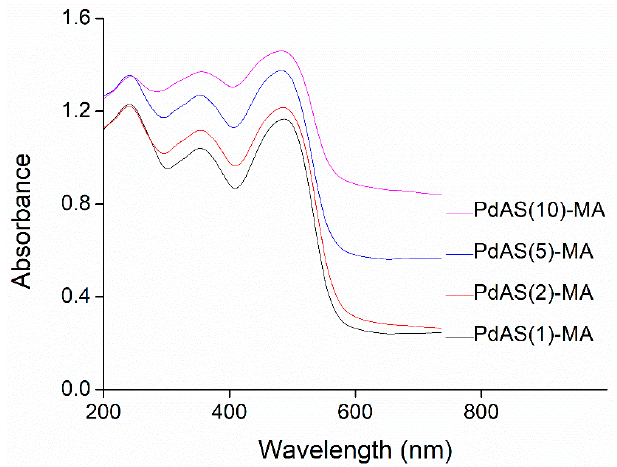
Figure 5. DRS UV–vis spectra for the PdAS(x)-MA catalysts.